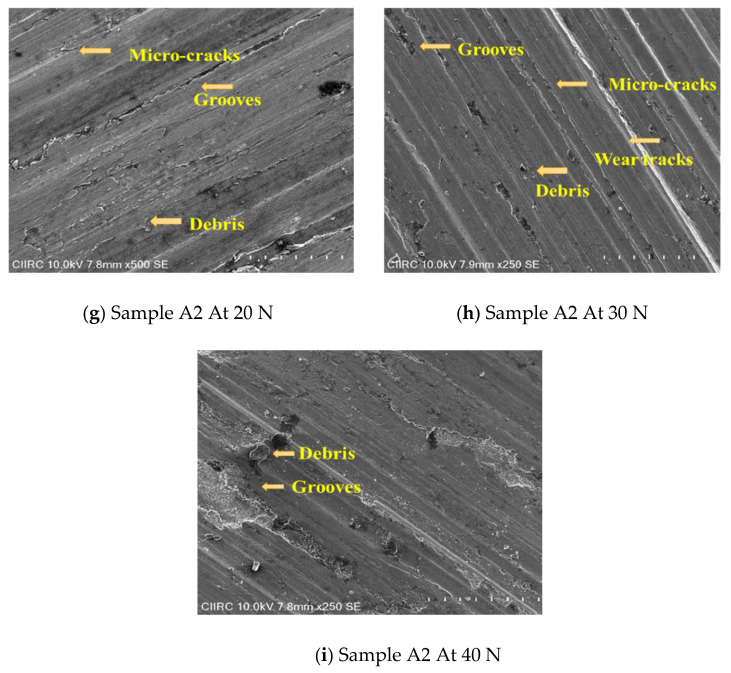
Figure 19. Worn surfaces of samples with respect to load ( a – c )—A0; ( d – f )—A1; ( g – i